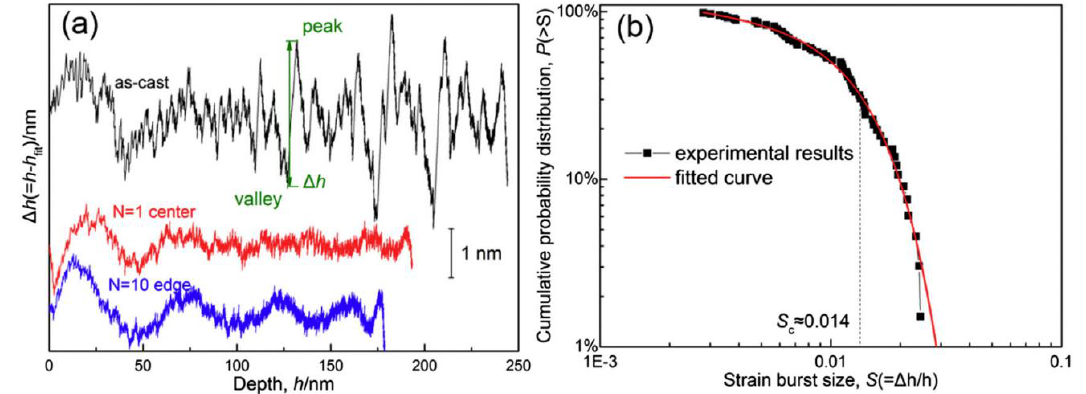
Figure 28. (a) Depth change of each pop-in event (Δh) as a function of indentation depth (h) and (b) the cumulative-probability distribution of the strain-burst size of the as-cast Al 0.3 CrCoFeNi HEA (reproduced from Reference [287] with permission).